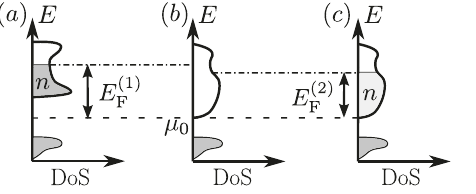
Fig. 1 Illustration of the two operational de fi nitions of E F . a , b E ð 1 Þ F is de fi ned in Eq. (1) as the difference between the chemical potential at density n (panel a) and the limiting value of the chemical potential μ 0 at which n approaches the value, n 0 , it takes in a reference insulating state (panel b ). c E ð 2 Þ is de fi ned by Eq. (2) in F terms of the density of states ρ ( ε ) of a single electron excitation added to the reference insulating